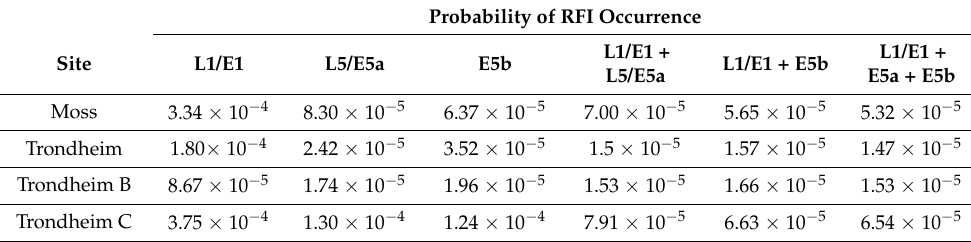
Table 5. Probability of RFI occurrence per site and band/band combination considering the L1/E1, E5a and